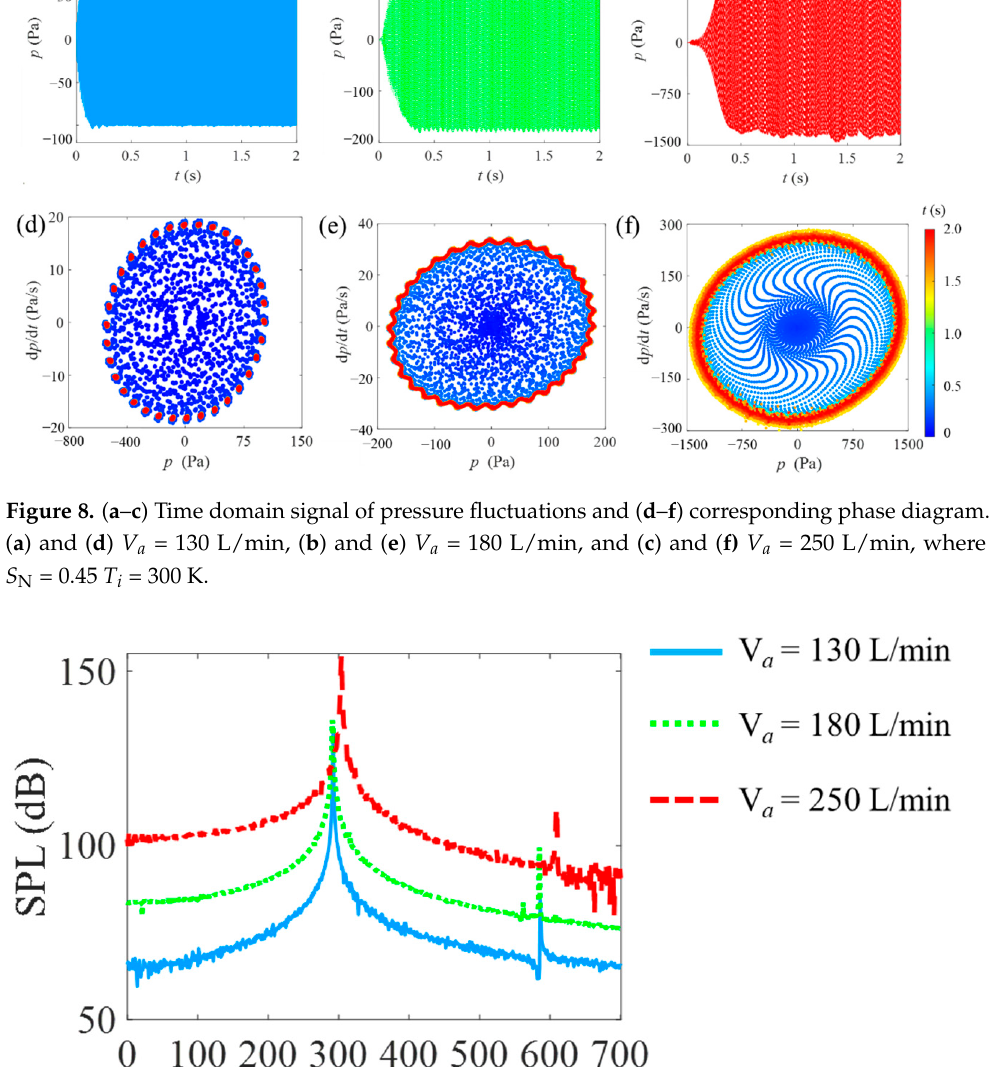
Figure 9. Frequency spectrum of acoustic pressure fluctuation of different V a at S N = 0.45 and T i = 300 K.